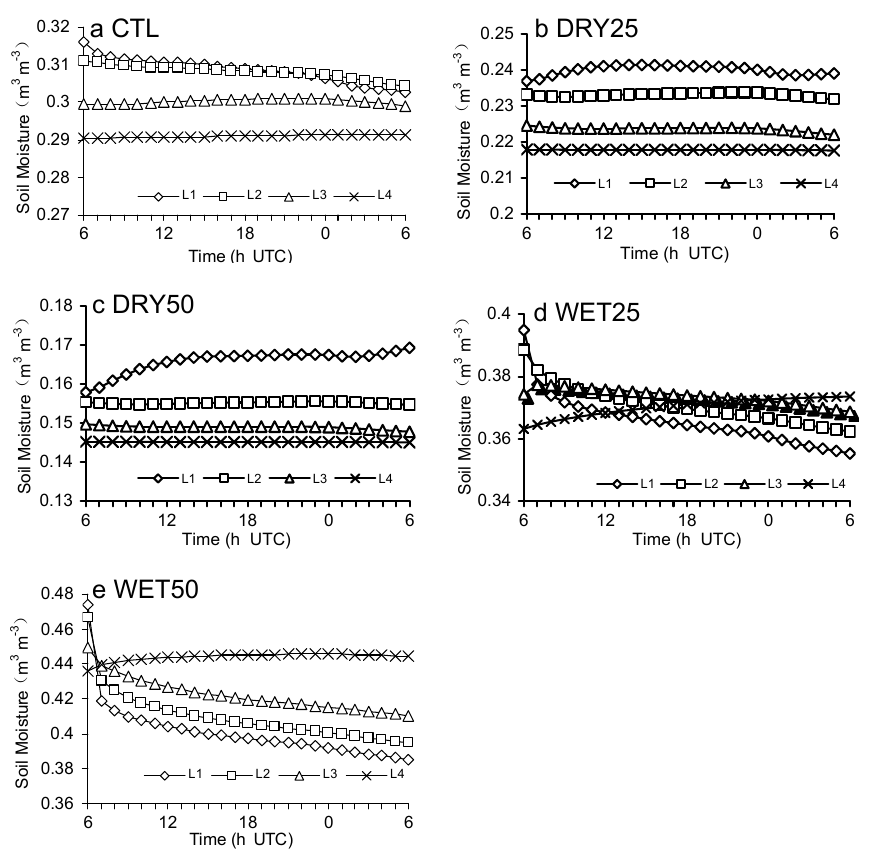
Figure 6. The mean hourly variations in soil moisture (unit: m 3 m − 3 ) in the five groups of 24h simulations for 20–29 July 2003, where L1, L2, L3 and L4 represent 10, 30, 60 and 100cm thick soil layers,